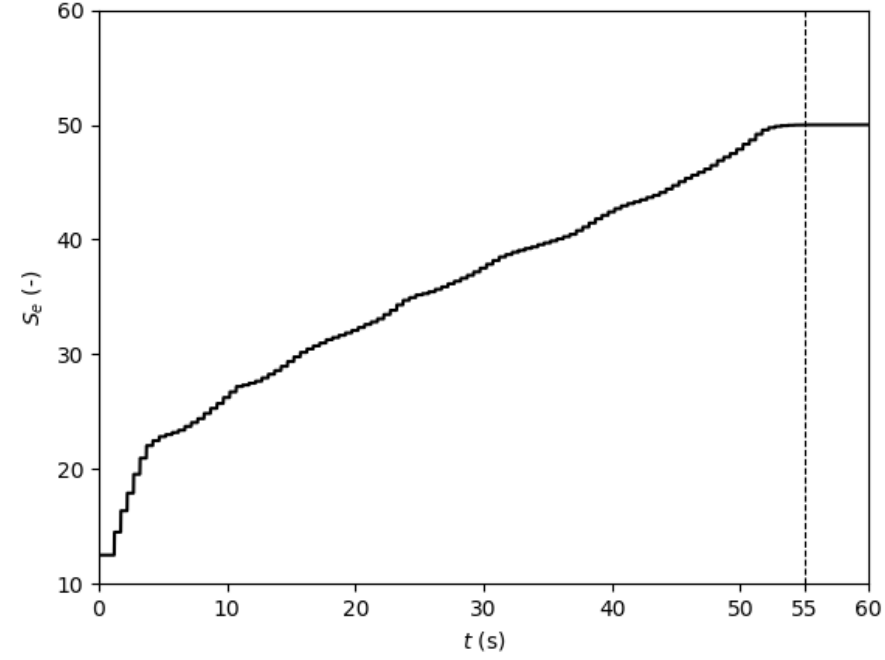
Figure 19. Effective swirl number profile, feedback with complete regulation law, case